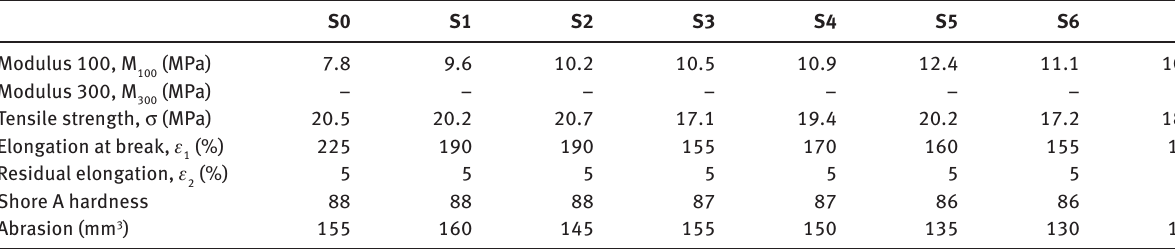
Table 4 Mechanical properties of the investigated rubber